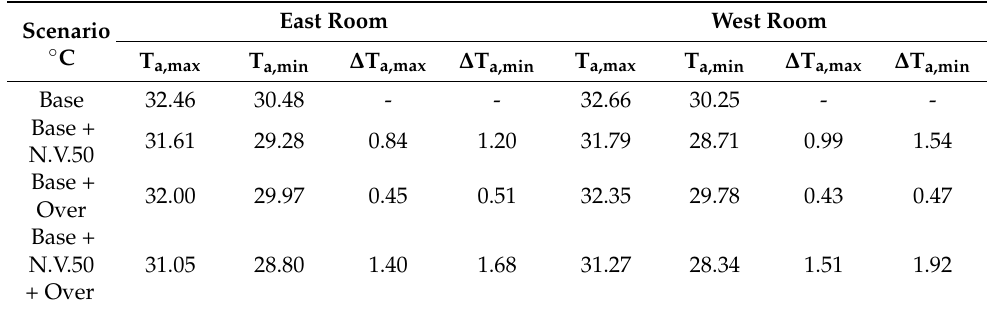
Table 8. Mean indoor temperature for the investigated cases for east and west rooms.